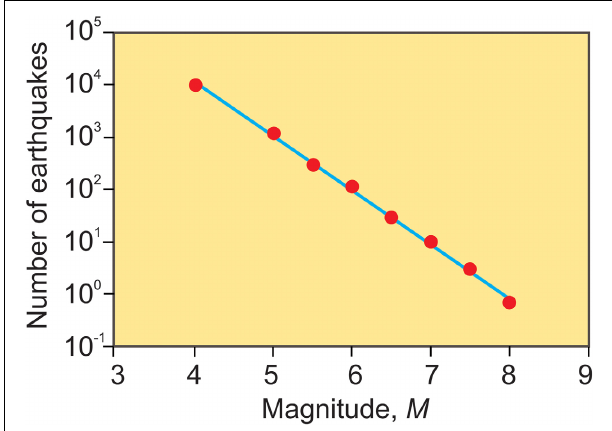
FIGURE 2 | Number (frequency) of earthquakes per year vs. their magnitudes. The plot shows the earthquakes in the world during the period from 1904 to 1980 (modified from Kanamori and Brodsky, 2004). This is a semi-logarithmic plot with a slope of − 1. For the Gutenberg-Richter law, log N = a − bM , where a and b are constants and M the magnitude (a logarithmic measure), the slope of − 1 implies a b -value of